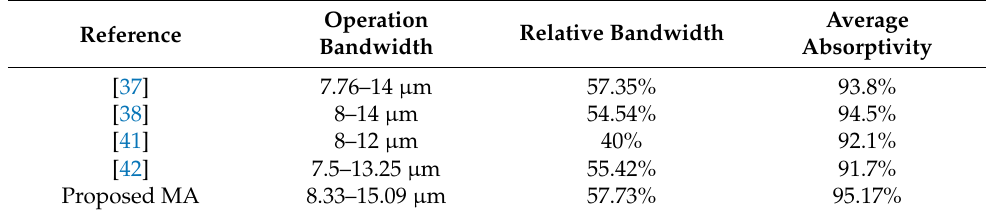
Table 2. Comparison between proposed MA and those designed in previous